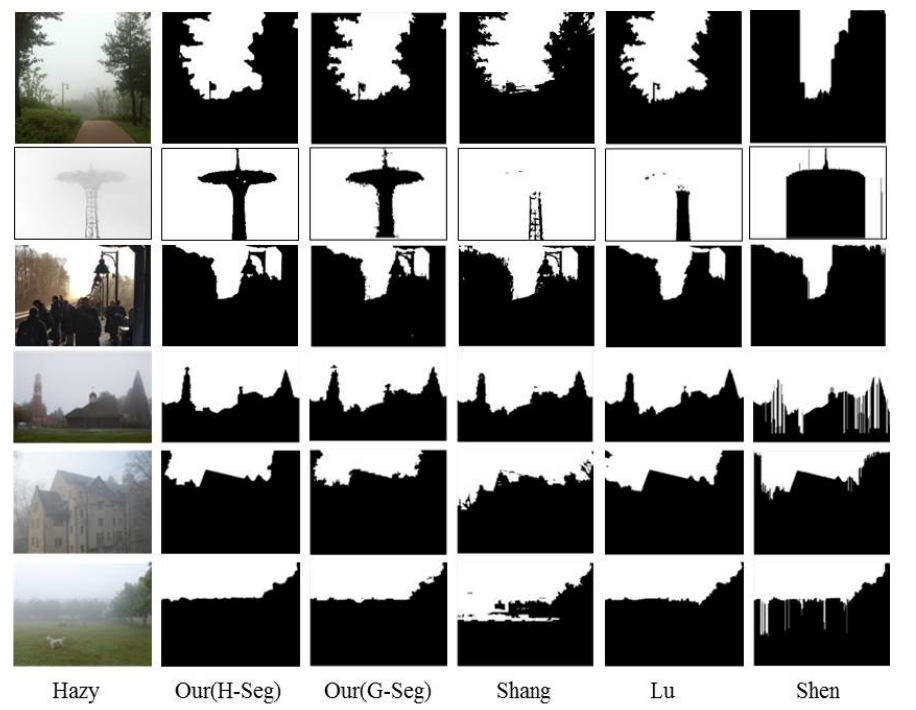
Figure 5. Sky detection results on the HazySky dataset. The first column is the hazy images. The second column to the last column are the results of Our(H-Seg), Our(G-Seg), Shang’s [14], Lu’s [6] and Shen’s [1]